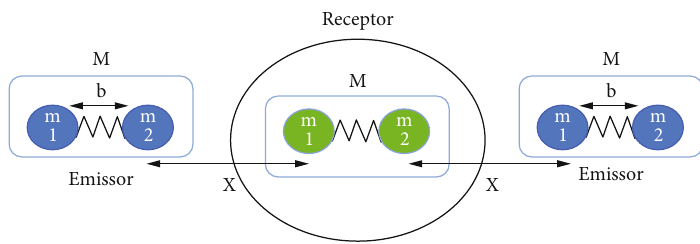
Figure 4: Model of the detector and the emitter of periodic tidal gravitational signals. Source: The authors [25].